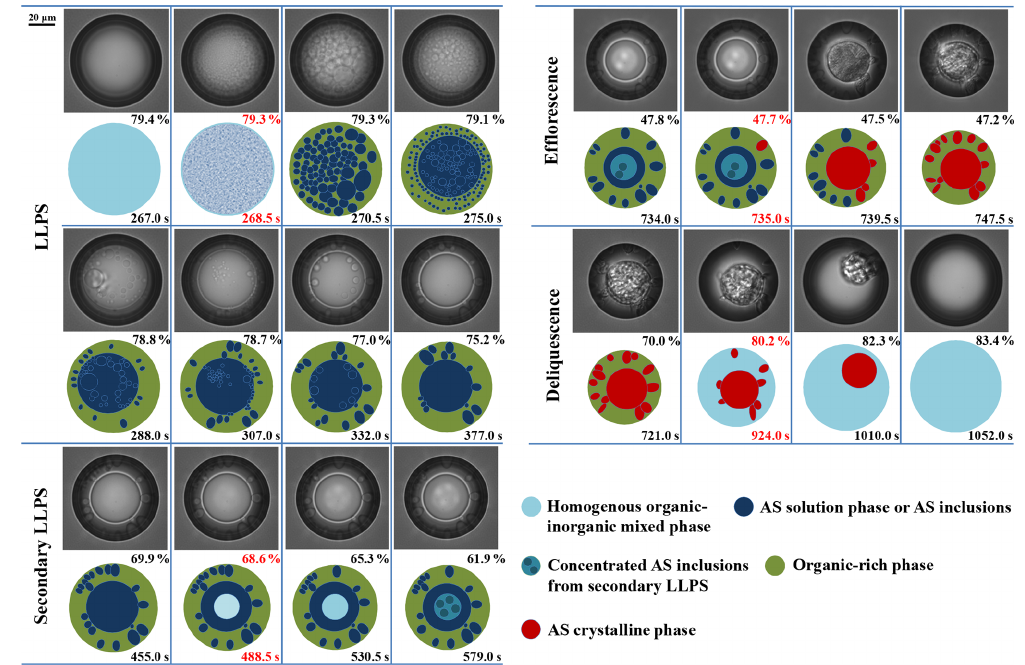
Figure 2. Optical images and corresponding illustrations of the mixed 1, 2, 6-hexanetriol / AS particle with OIR = 1 : 1 during LLPS, secondary LLPS, efflorescence and deliquescence. Below the optical images are the illustrations. The corresponding RH and time are given in each frame. The RH and time in red indicate the occurrence of phase